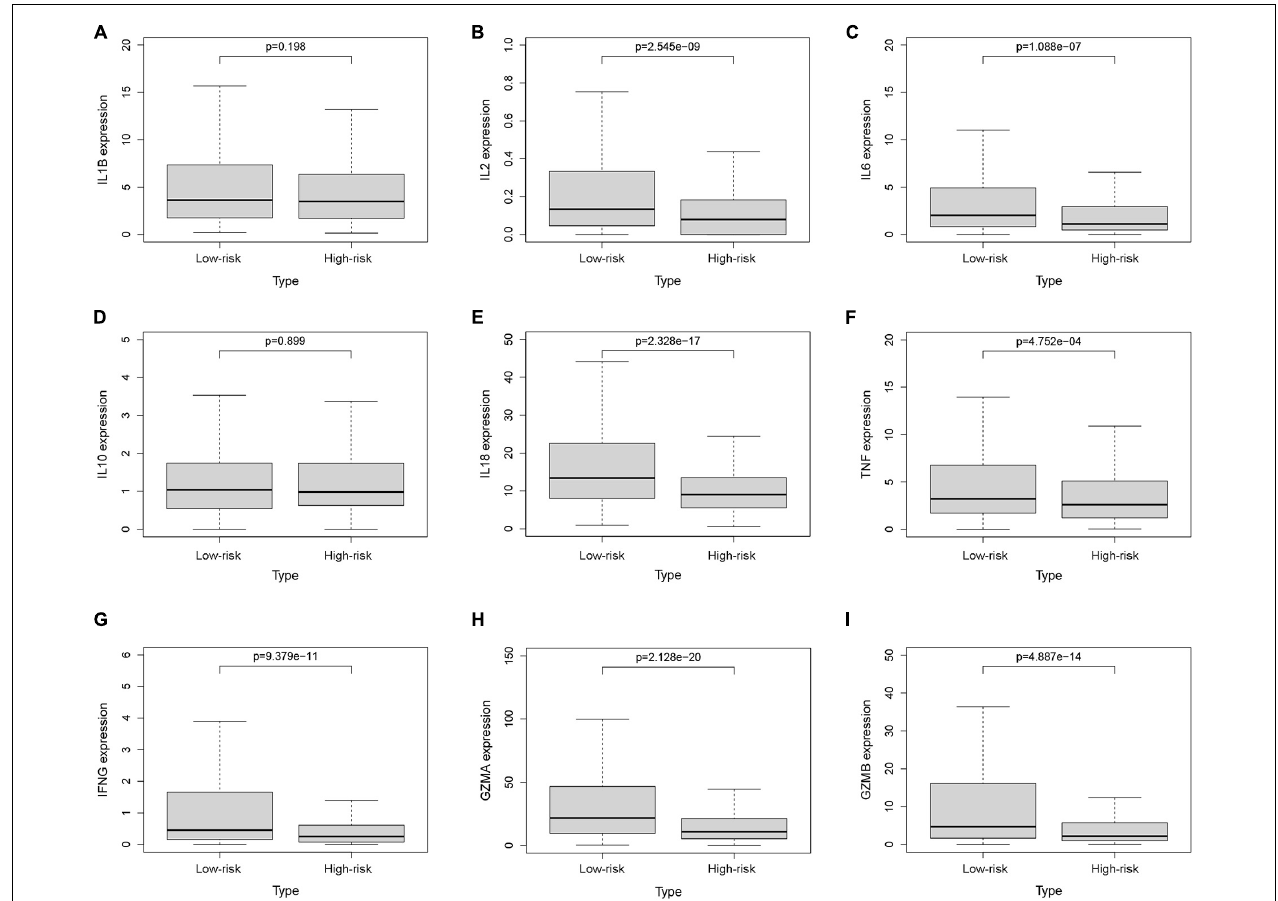
FIGURE 9 | The expression levels of cytokines. The expression levels of IL-1 β (A) , IL-2 (B) , IL-6 (C) , IL-10 (D) , IL-18 (E) , TNF (F) , IFN- γ (G) , GZMA (H) , and GZMB (I) between the low-risk and high-risk